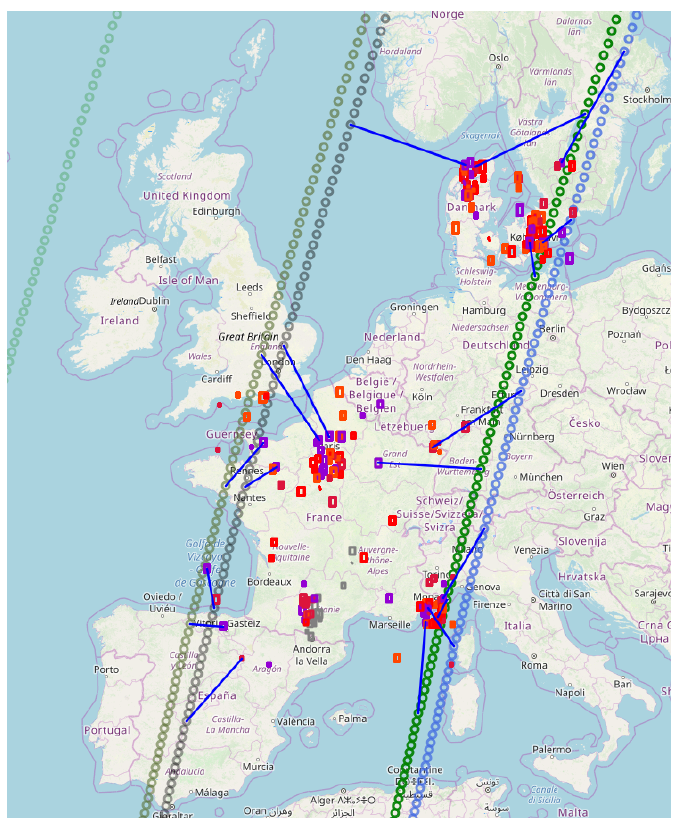
Figure 2. Illustration of generated scenario, i.e., 200 requests and satellite path from 2019-30-11-09-50 and 2 h ahead for SPOT 6, 7, and PLEIADES A and B, illustrated by dark green, green, blue, and black paths, respectively. The granularity is 5 seconds. Note that the request color defines its priority, and the blue lines represent an acquisition made. In addition, the performance measures for the illustrated schedule are shown in Table